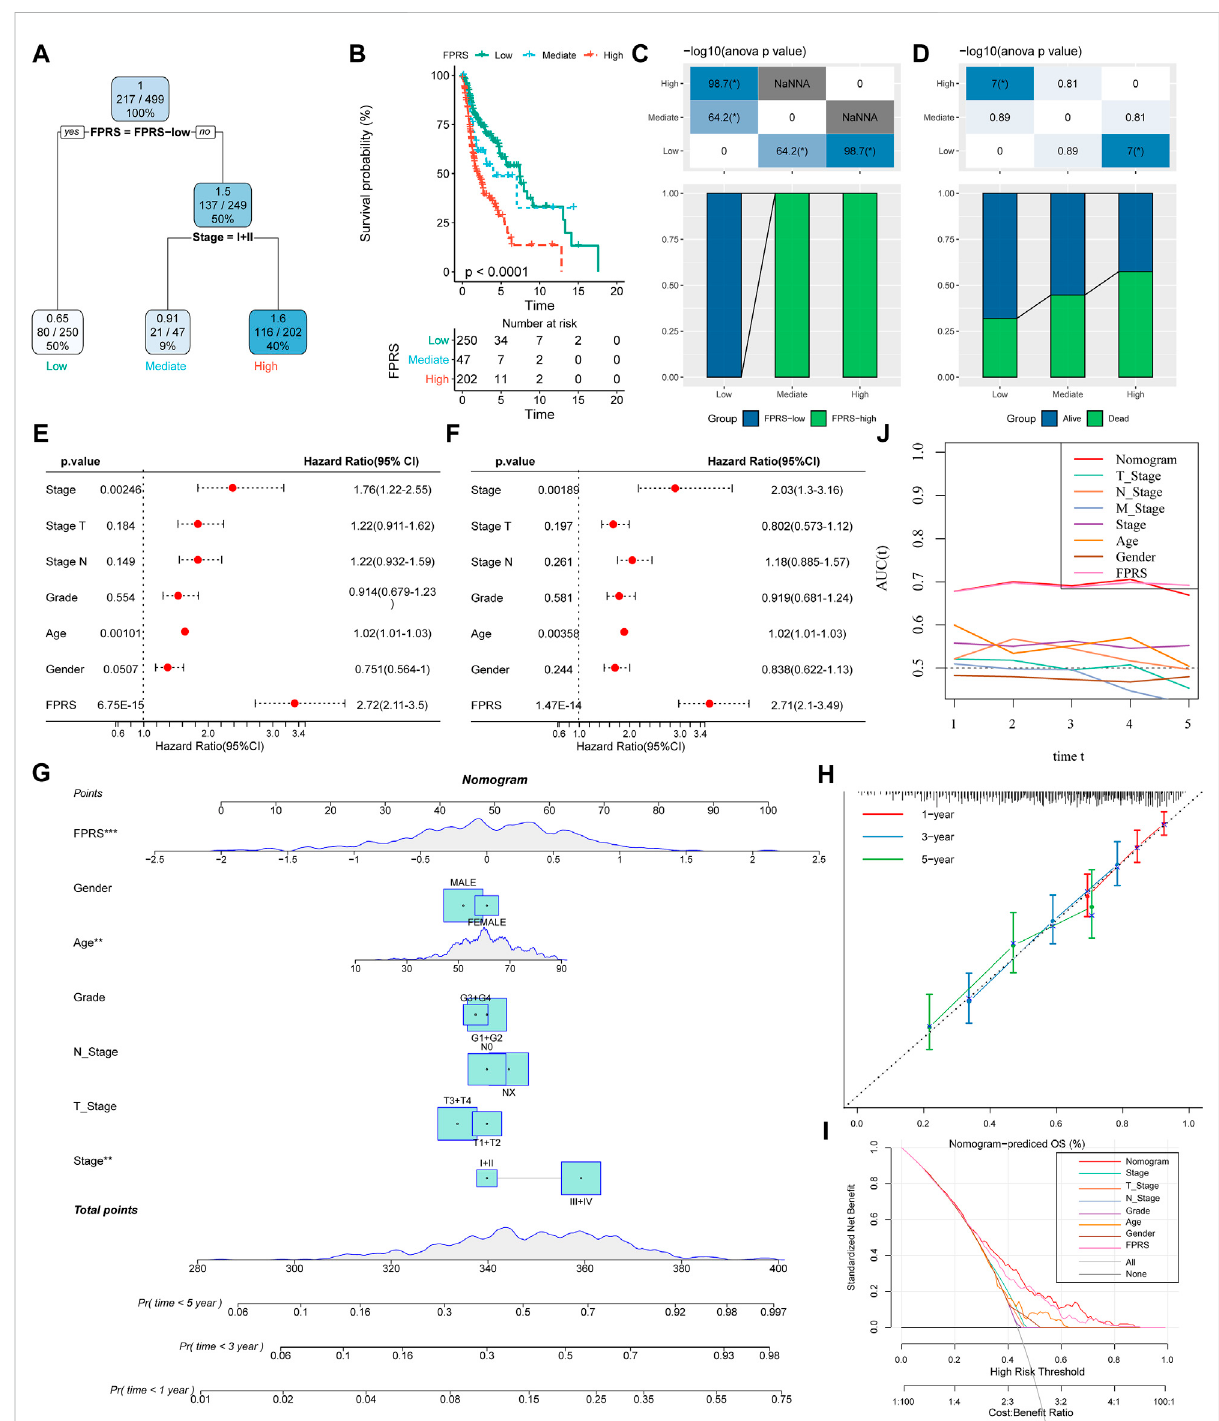
FIGURE 12 FPRS combined with clinicopathological features to further improve prognostic models and survival prediction. (A) Patients with full-scale annotationsincludingFPRS, stage,genderandagewereusedtobuildasurvivaldecision treetooptimizeriskstrati fi cation; (B) Signi fi cantdifferences of overall survival were observed among the three risk subgroups; (C,D) Comparative analysis between different groups; (E,F) univariate and multivariate Cox analysis of FPRS and clinicopathological characteristics; (G) nomogram model; (H) 1, 3, and 5-year calibration curve of nomogram; (I) Decision curve of nomogram; (J) Compared with other clinicopathological features, the nomogram exhibited the most powerful capacity for survival